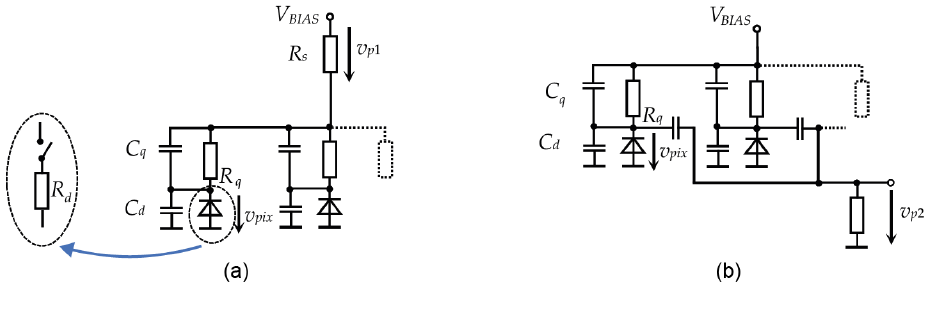
Figure 1. Methods of sensing the output pulses of analog SiPM: ( a ) Measuring the supply current pulses v p 1 through a small series resistor R s [15]. ( b ) A special output v p 2 with capacitive coupling [7].